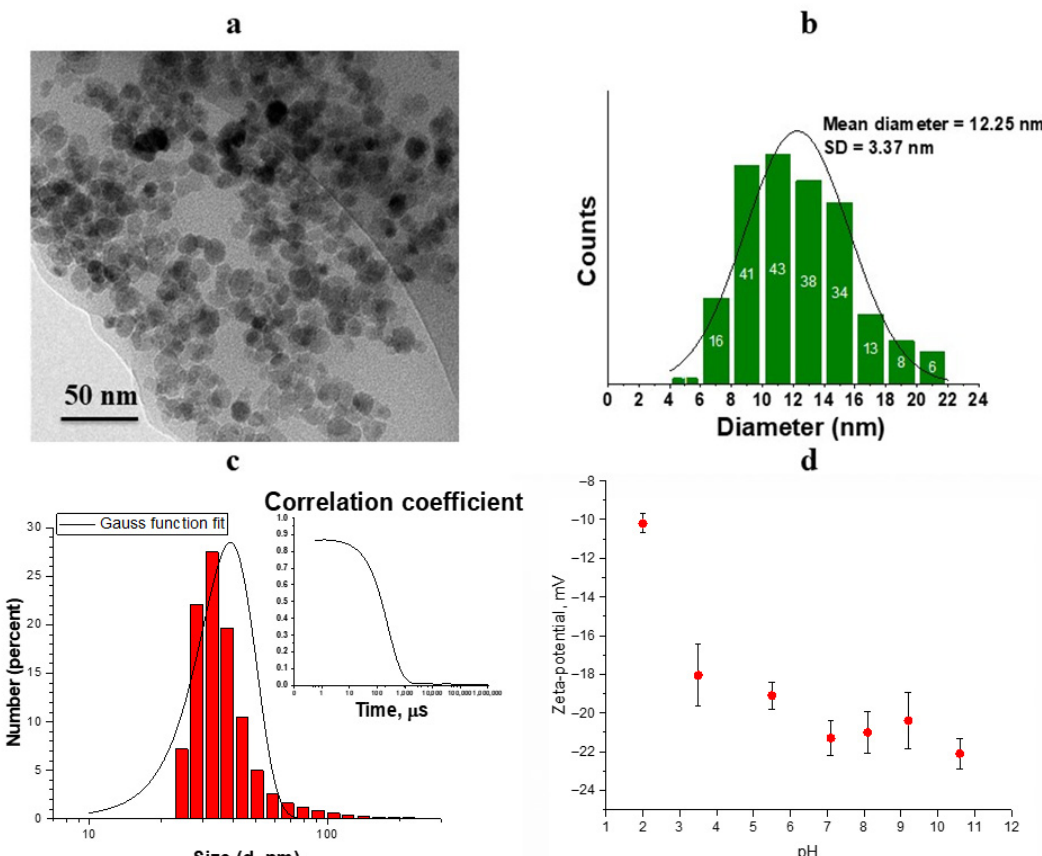
Figure 1. ( a ) TEM image of the magnetic nanoparticles, ( b ) size distribution of nanoparticles from TEM data approximated by Gaussian function, ( c ) DLS data of the MNPs hydrodynamic size distribution, ( d ) Zeta-potential of MNPs as a function of